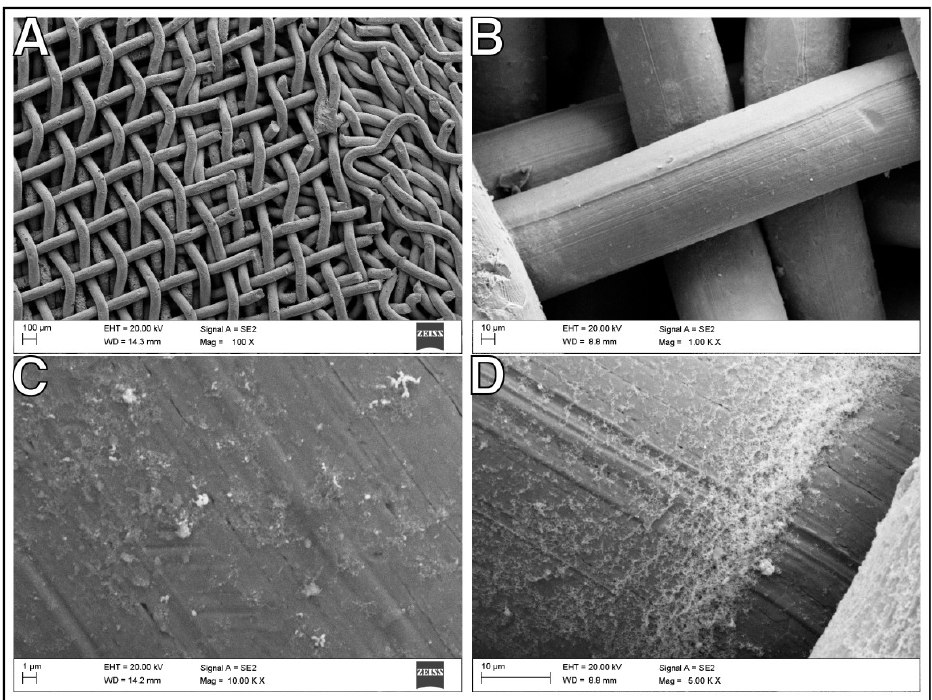
Figure 2. Scanning electron microscopy (SEM) images for nanometal/Ni-wool catalysts;( A ) Ni-wool support fibers with Ru nanoparticles, ( B ) Ru nanoparticles on the support surface, ( C ) Ru nanopar- ticles (red spots) after EDS mapping, ( D ) Re nanoparticles on the fiber surface, ( E ) Pd nanoparticles on the fiber edge surface, ( F ) support fibers covered with Au nanoparticles.